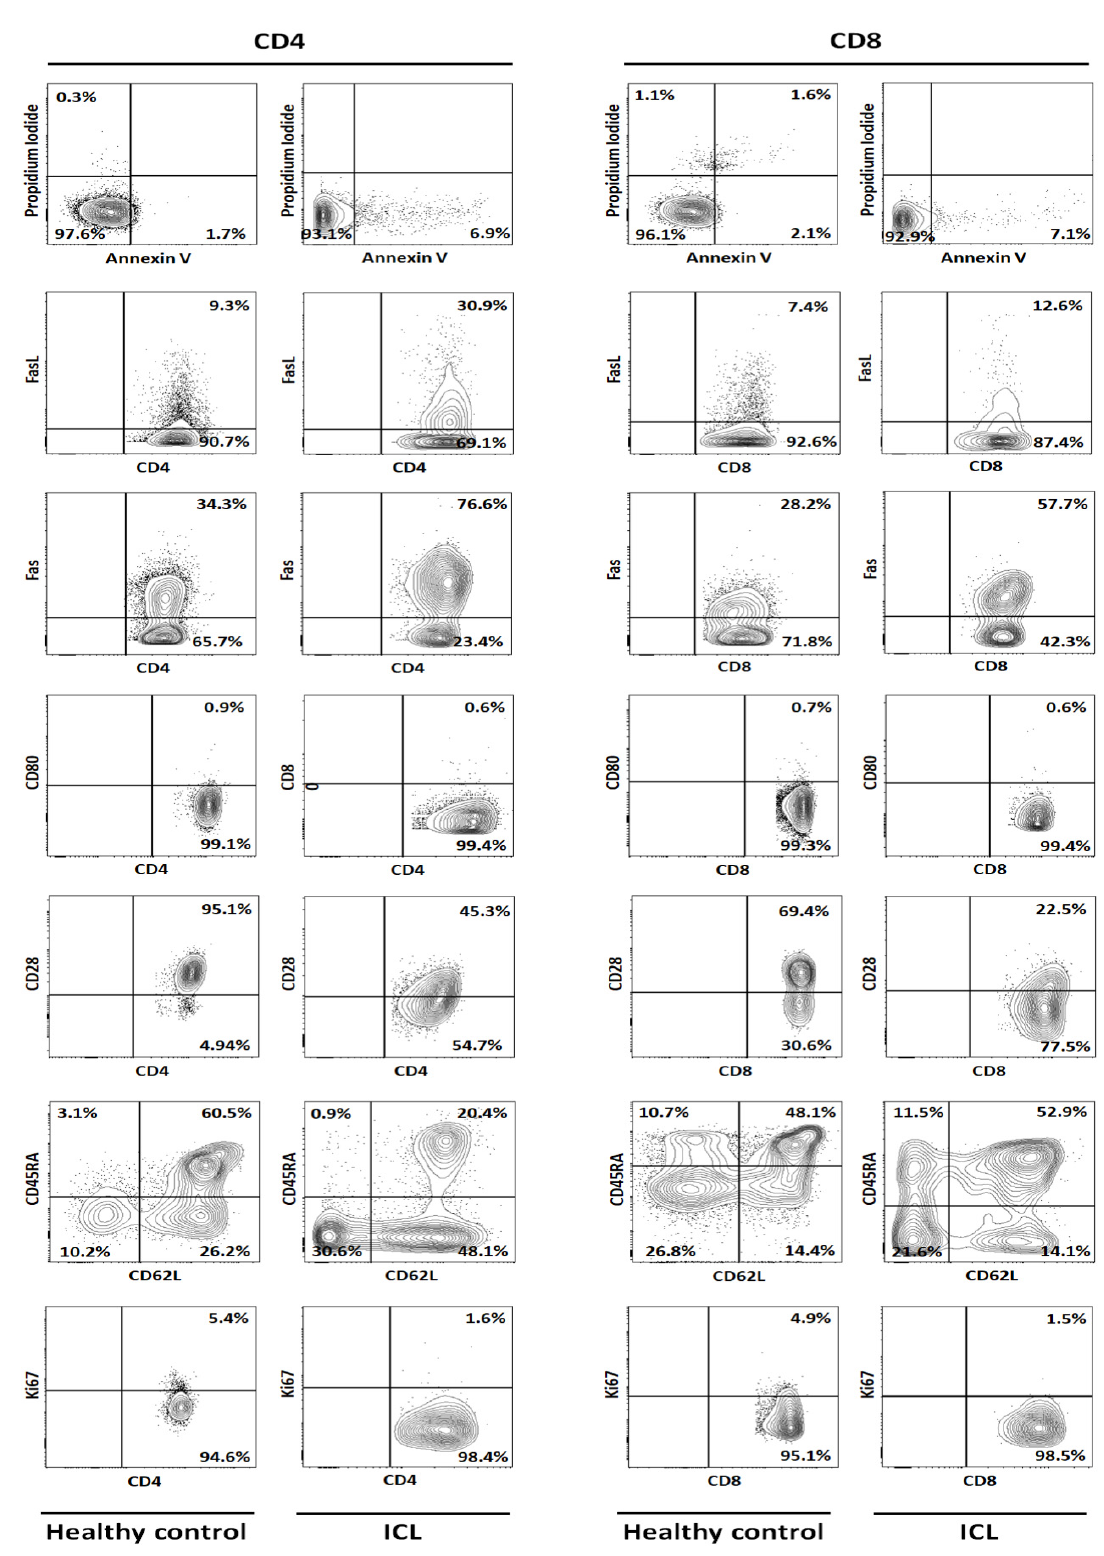
Figure 1. T cell phenotype from idiopathic CD4 T cell lymphocytopenia (ICL) patient and healthy control. Representative flow cytometric data of markers for activation (HLA-DR+), costimulatory and inhibitory molecules (CD28, CD80, CD86, CD152, PD-1, PDL-1), regulatory T cells (CD25+Foxp3+), apoptosis (AnnexinV+Propidium iodide, Fas, FasL), naïve T cells (CD54RA+CD62L+), and proliferation (Ki67+) expressed on CD4 and CD8 T cells from ICL patient and healthy control. First, the living population was gated on total cells analyzed. Then, on living CD45+ cells, CD3+ cells were gated and finally CD4 and CD8 T cells were gated on CD3+